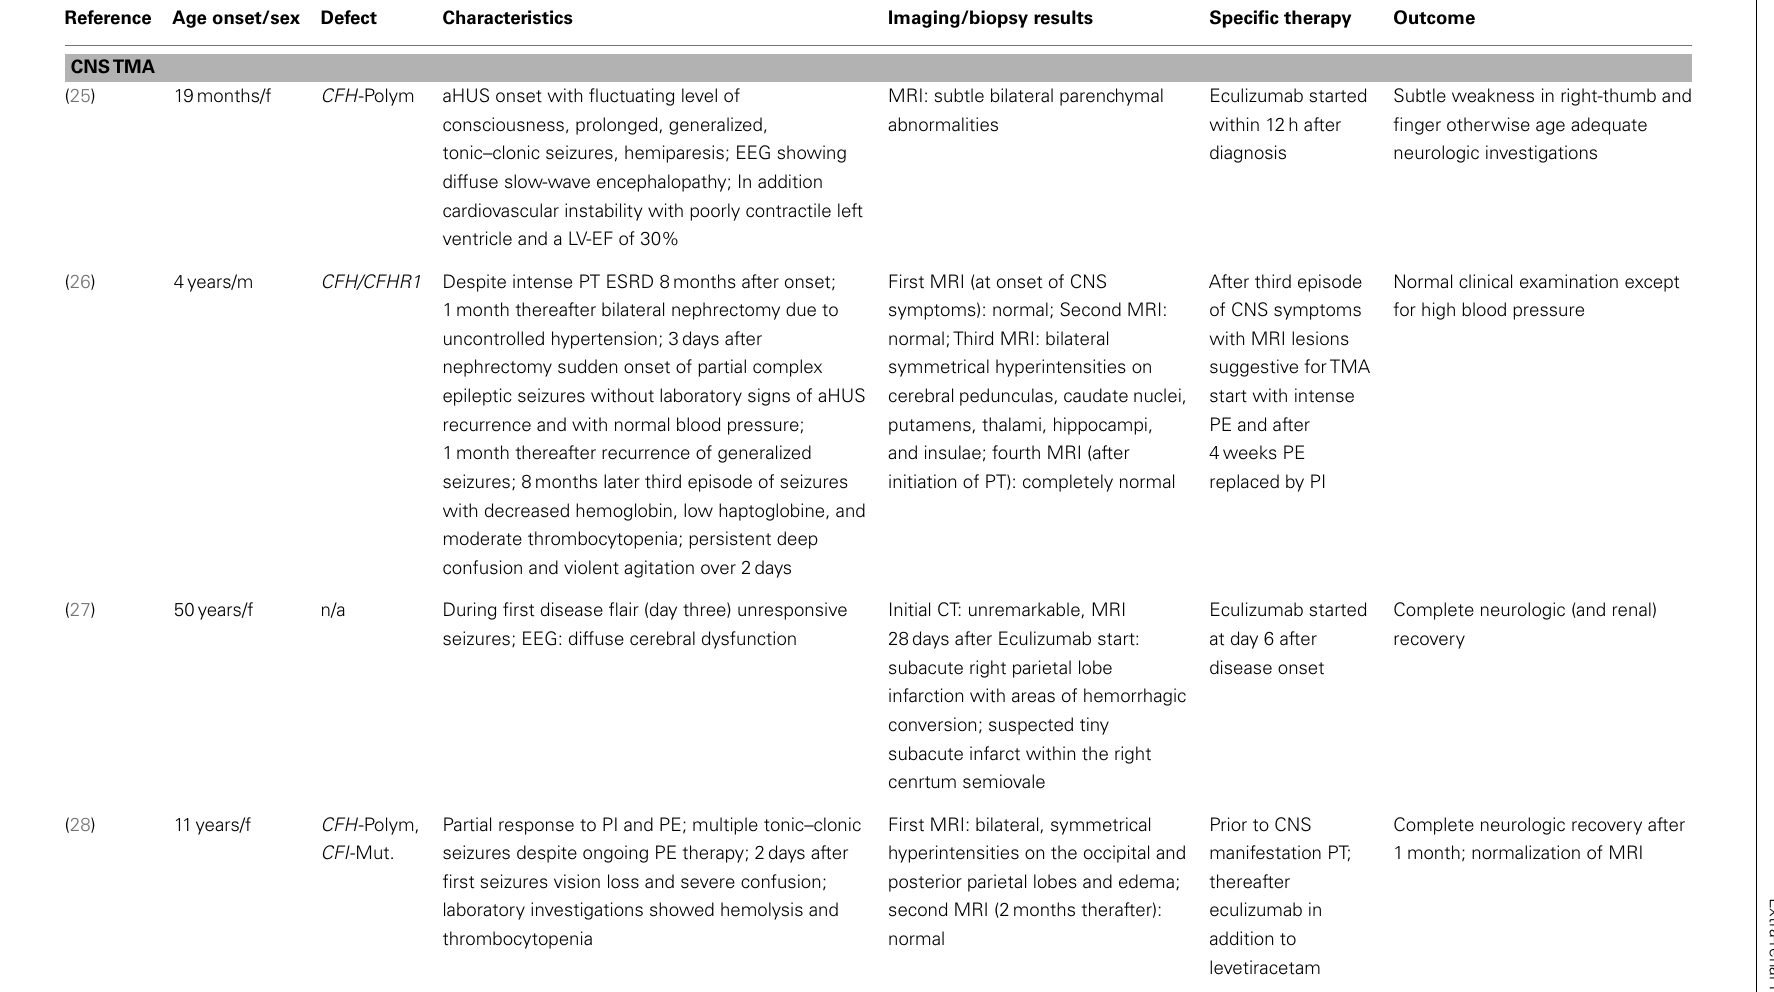
Table 1 | Overview of case reports describing cerebrovascular CNS manifestations (CNS,TMA, and macrovascular CNS manifestations)